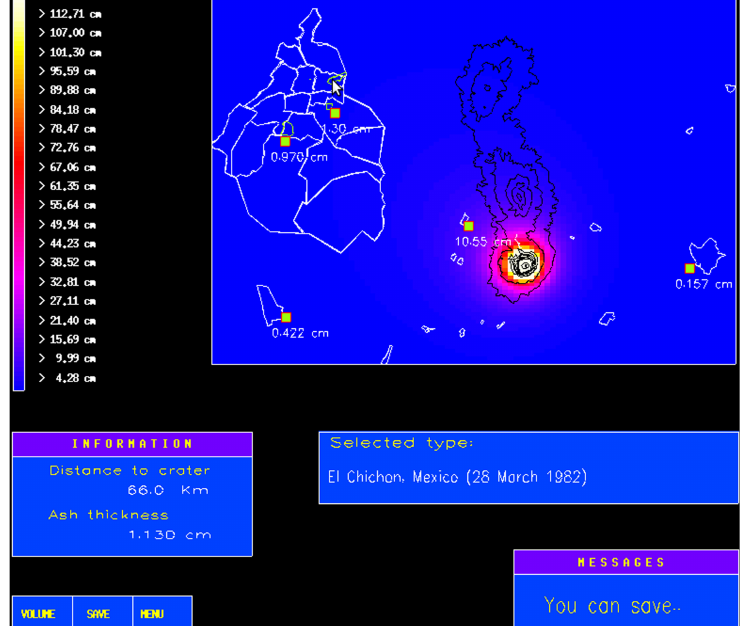
Fig. 10. SECCVO ashfall scenario of an eruption similar to the 28 March 1982 eruption of El Chich´on volcano occurring at Popocat´epetl volcano, assuming a prevailing wind blowing towards Mexico city (N 315 ◦ NW). The scenario displays the Federal District of Mexico, and other main towns and villages. The simulator estimates an ash deposit 1.30cm thick in “Central de Abasto” (main food distribution center of Mexico City), 0.97cm in the National Autonomous University of Mexico main campus, 0.42cm in Cuernavaca City, 10.55cm in Amecameca, and 0.157cm in Puebla City. The displayed Information window shows a deposit 1.13cm thick at 66km to the NW of the volcano, the position of the Mexico City International Airport marked with the